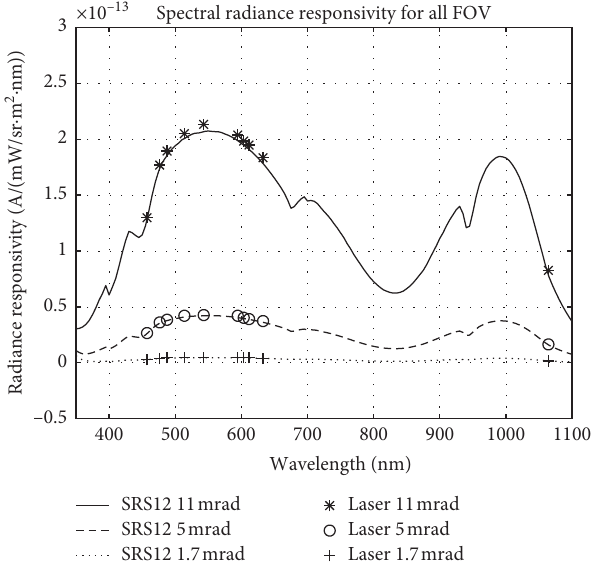
Figure 3: Spectral radiance responsivity for both laser-based and reference standard measurement system for all mrad FOV values.